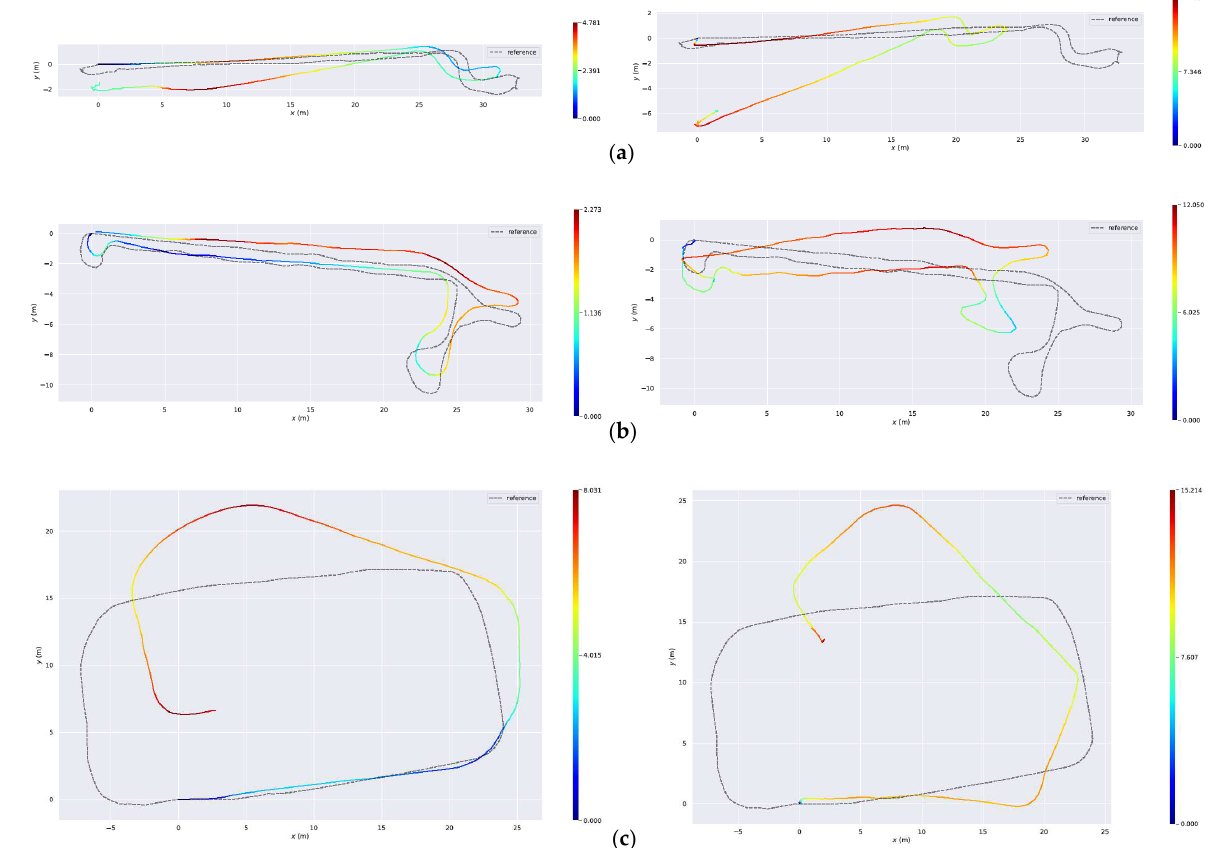
Figure 10. The trajectories are estimated with Struct-PL-SVO (the first column) and PL-SVO (the second column) from the ceiling dataset (ground truth in gray), and the color represents the absolute error of the trajectory. ( a ) The trajectory estimated in Floor 3 sequence 1. ( b ) The trajectory estimated in Floor 1 sequence 3. ( c ) The trajectory estimated in Parking lot sequence 5. (It is noticeable that the color represents the error of the trajectory only in a single image, and the unit is inconsistent between different images).